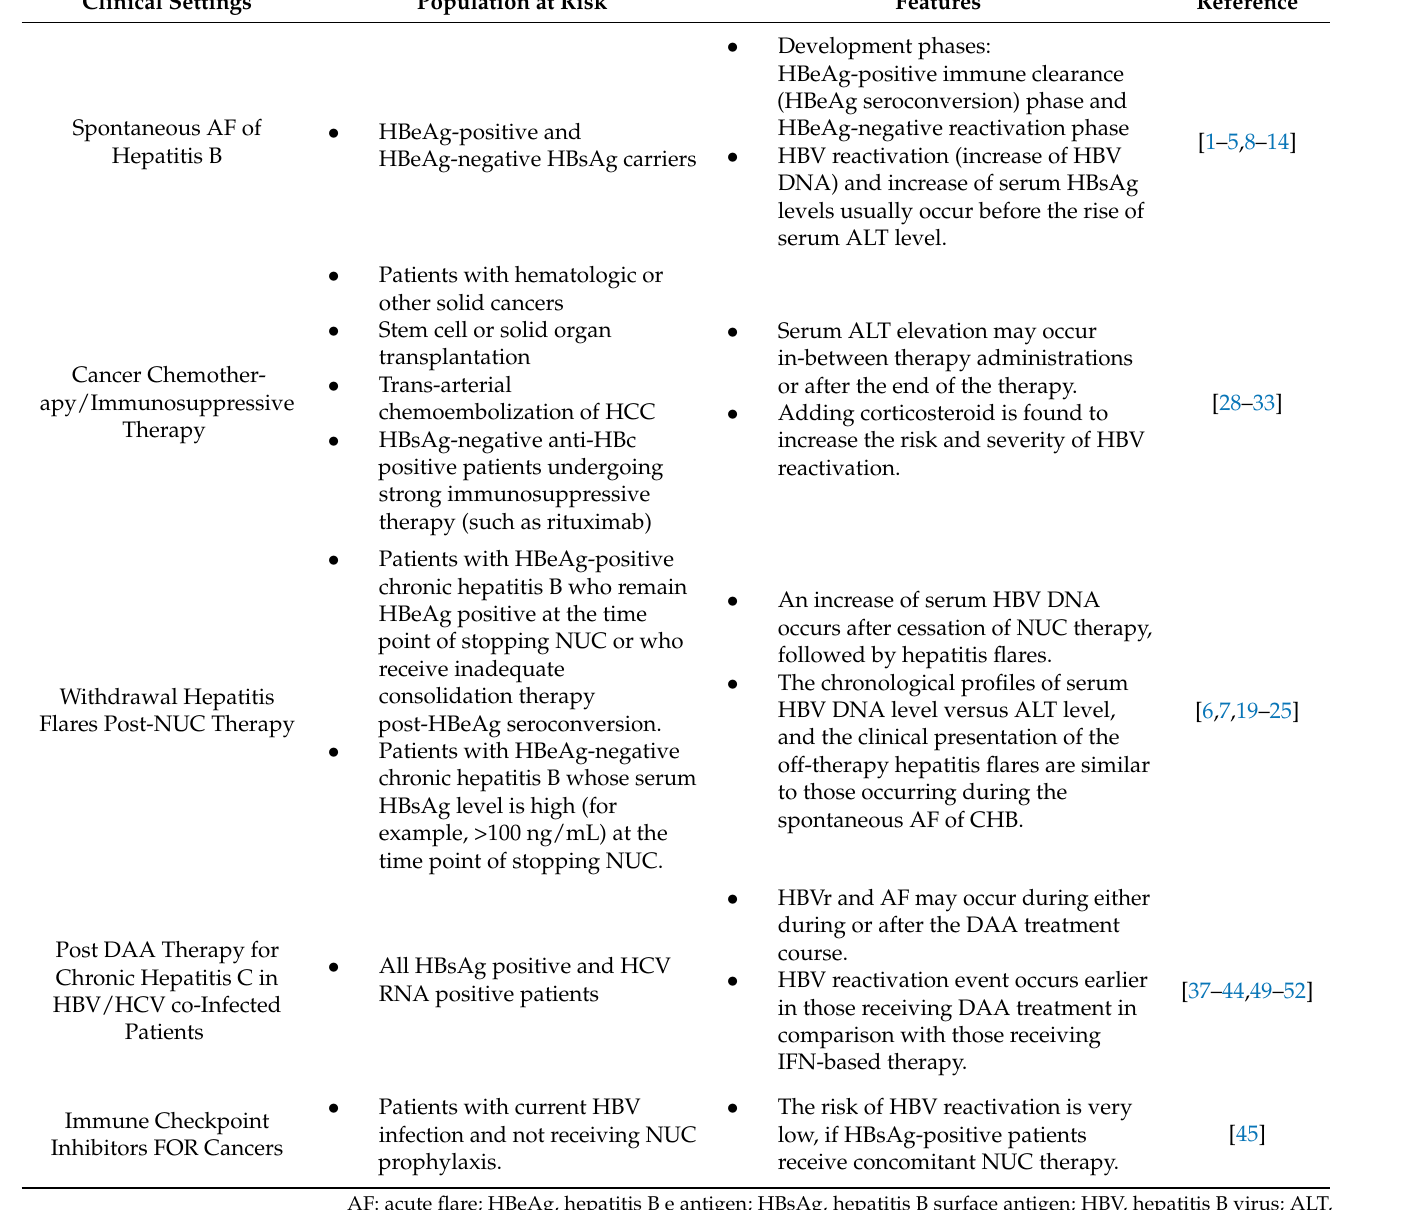
Table 1. Clinical features of acute flare of chronic hepatitis B in various clinical